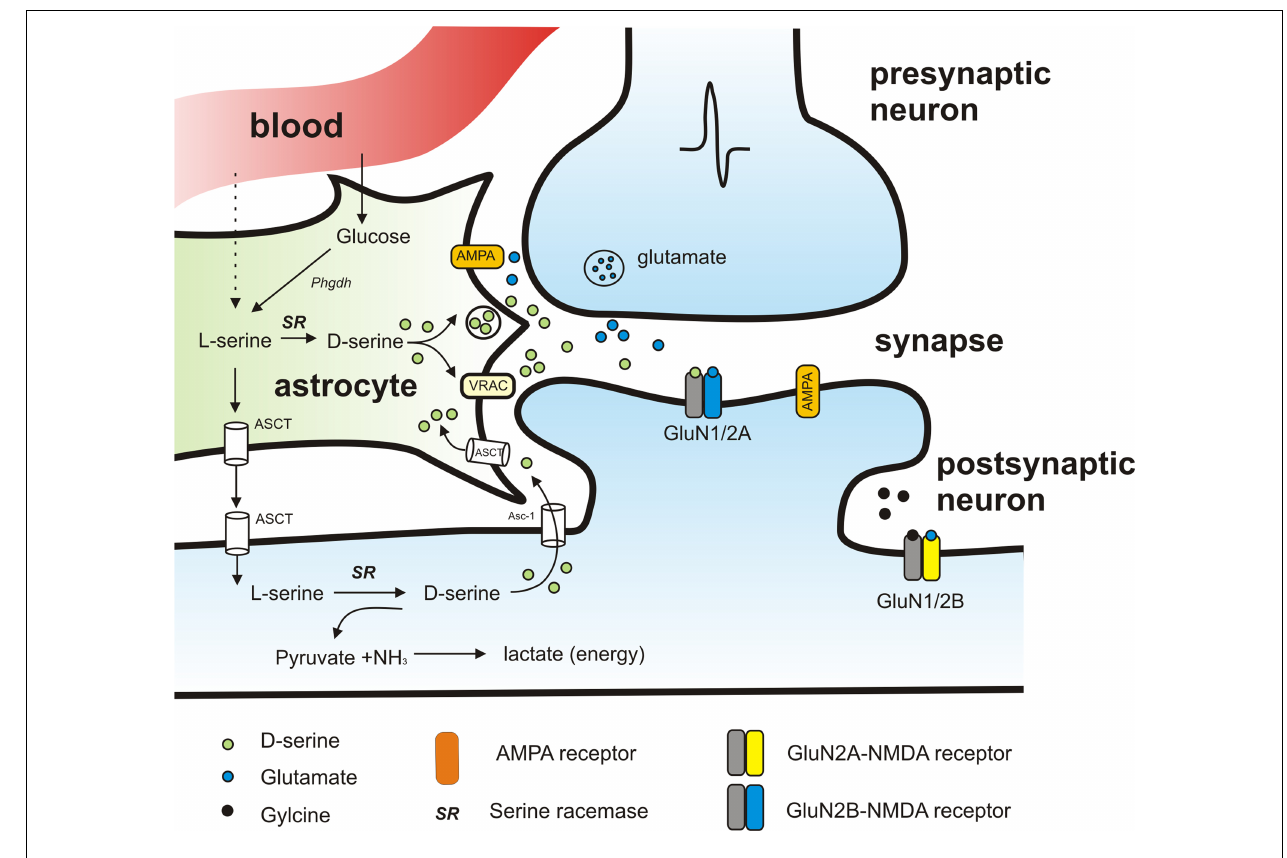
containing GluN2B preferentially bind glycine instead of D -serine. SR localized in neurons synthesizes D -serine from L -serine. L -serine is shuttled to neurons from astrocytes through amino acid transporters (ASCT). SR is also responsible for the degradation of serine resulting in production of pyruvate and